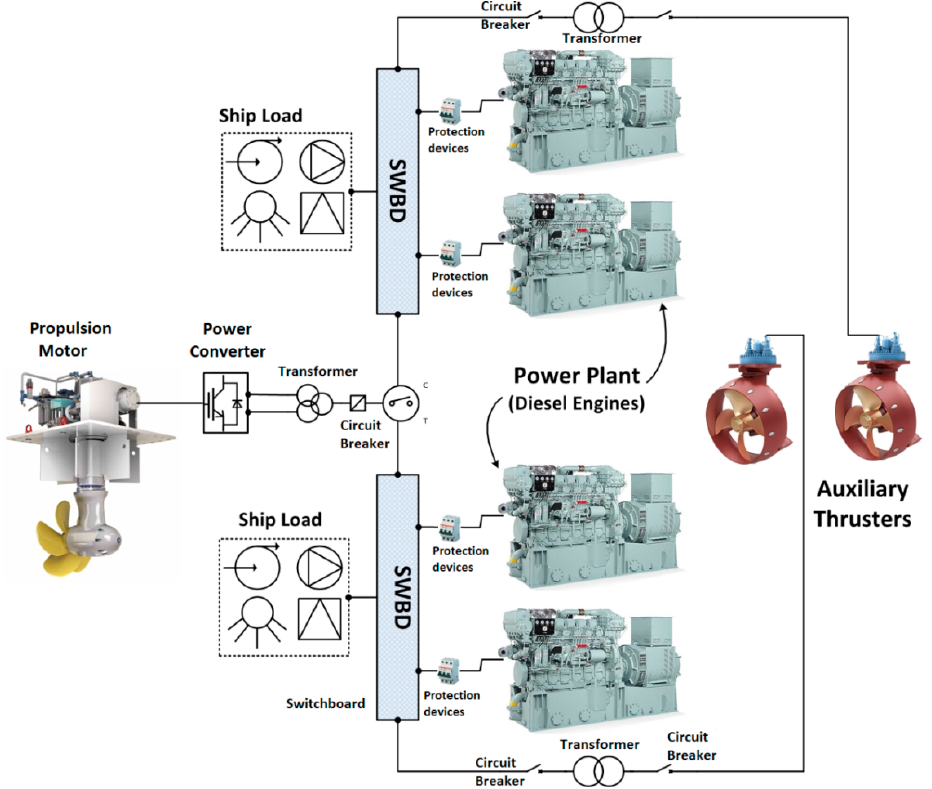
Figure 1. Generic diagram of a fully electrified shipboard power system.